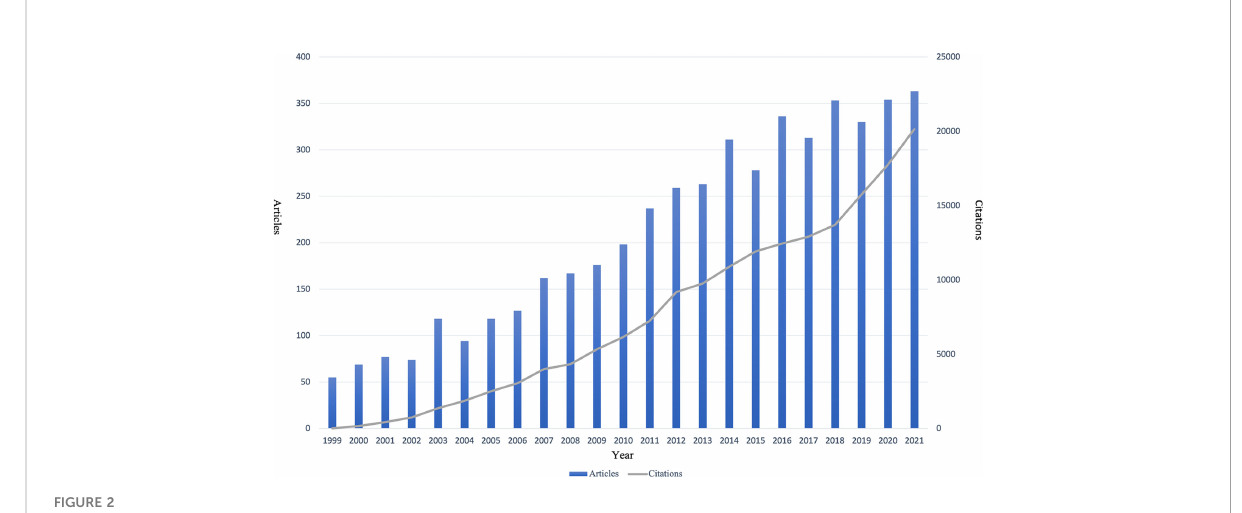
FIGURE 2 Quantitative analysis of the published articles per year.